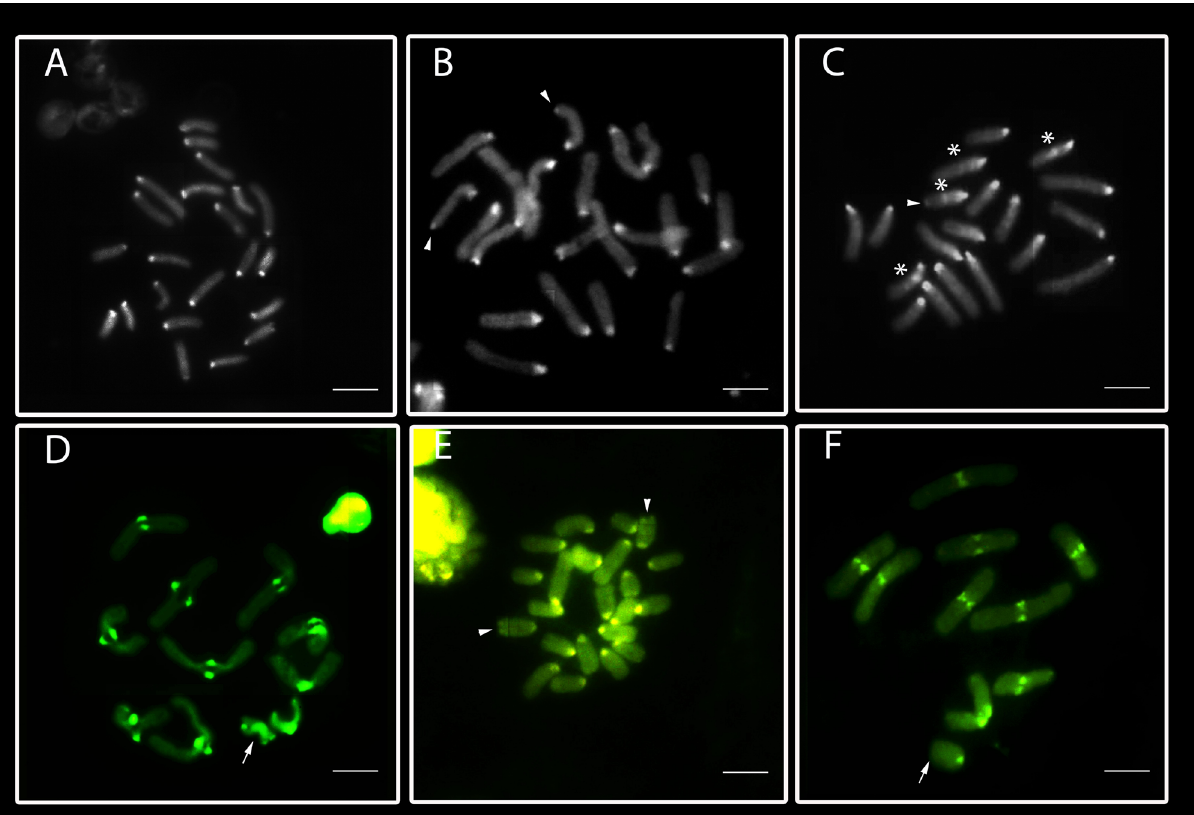
Figure 3 – Testicular cells of the three Lycosa species submitted to the C banding technique ( A, B, C ) and staining with fluorochrome CMA F ). The arrows indicate the sex chromosomes. In A, B, C, mitotic metaphases of L. erythrognatha with 2n♂= 22, X Park, State University of Londrina, Iguaçu National Park and Superagui National Park. , L. sericovittata with 2n♂= 22, X Londrina, L. gr . nordenskjoldi with 2n♂= 19, X0 of the Superagui National Park and Ilha Grande National Park respectively , showing pericentromeric heterochromatin on all chromosomes. In (B) some terminal heterochromatic markings (arrowheads) and in (C) interstitial heterochromatin (asterisk). In (D) diakinesis cell of L. erythrognatha with CMA 3+ pericentromeric regions. Mitotic metaphase of L. sericovittata (E) with CMA 3+ pericentromeric regions on all chromosomes: arrowheads indicate a pair of chromosomes with terminal markings. In (F) diplotene cell of L. gr. nordenskjoldi showing CMA 3+ pericentromeric markings on all chromosomes. Bar = 10